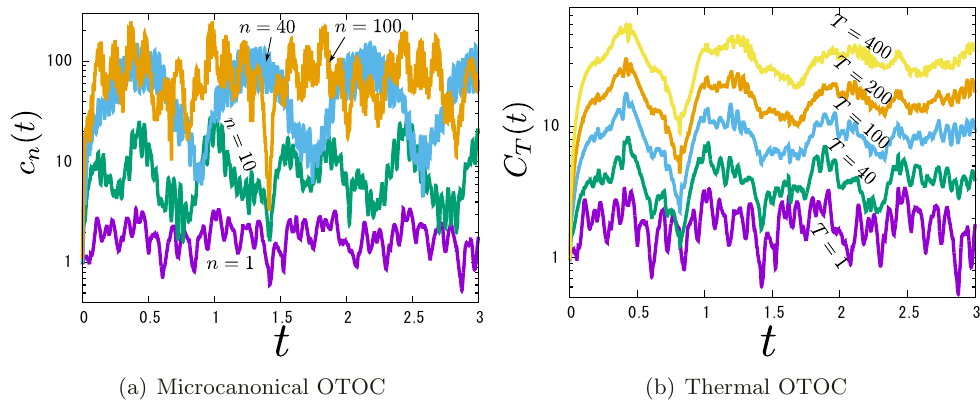
Figure 3 . Out-of-time-order correlators for the circle